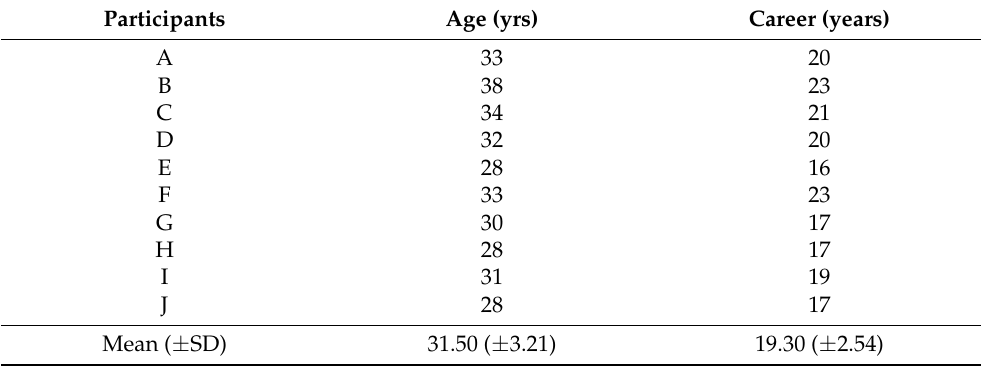
Table 1. Characteristics of the research participants ( n =